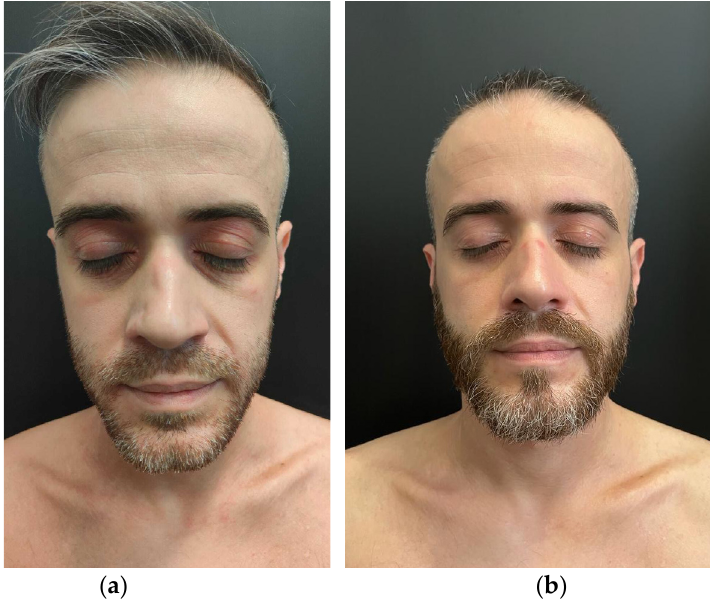
Figure 2. Atopic dermatitis. Clinical examination at the time of presentation showing eyelid edema, erythema, and lichenification together with peri-orbital darkening and facial pallor ( a ); then, after one month of therapy with upadacitinib, minimal signs of atopic dermatitis can be seen ( b ).